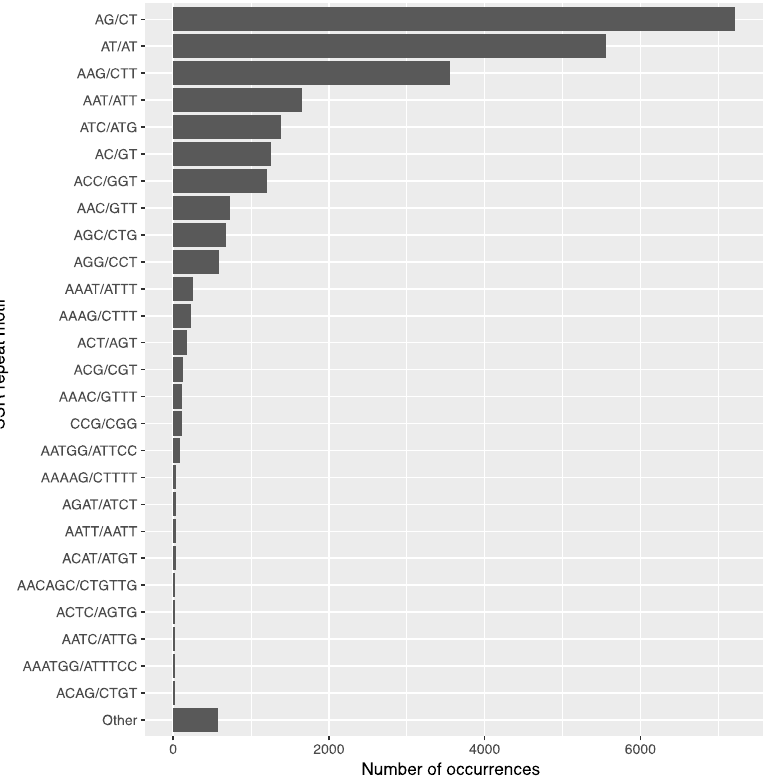
Figure 7. Most abundant SSR sequence motifs. Distribution of the most abundant SSR repeat motif sequences identified in assembled transcripts.